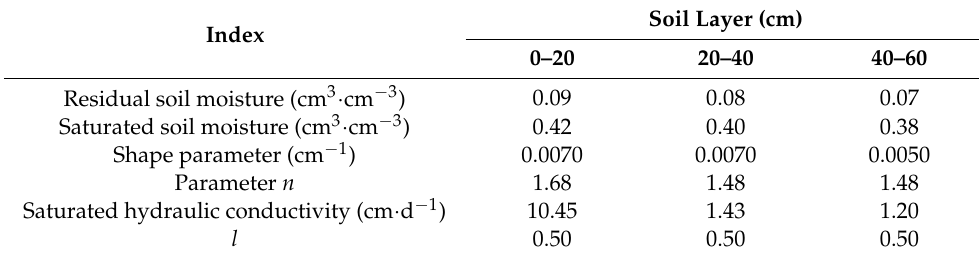
Table 2. Soil hydraulic parameters of different soil layers.